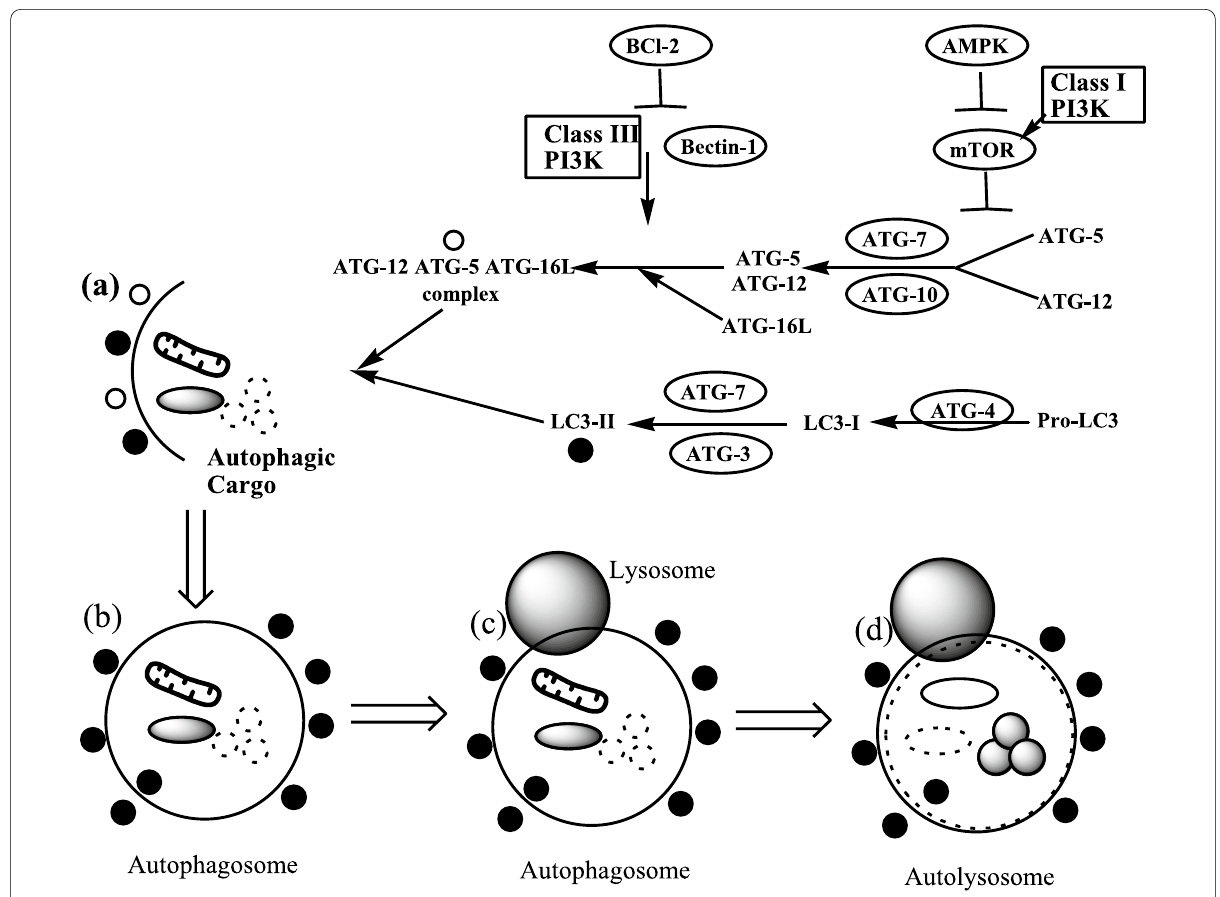
Fig. 3 Schematic representation of autophagy